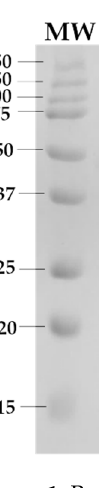
Figure 1. Purification of the recombinant endo-1,4- β -xylanase from M. pulchella (MpXyn10) expressed in A. nidulans A773. Gel SDS-PAGE (15%). MW: molecular weight standard ladder shown as kDa. Lane 01: Fraction eluted from Superdex 75 10/300 GL size exclusion chromatography column. Protein samples were stained with Coomassie Blue R-250.